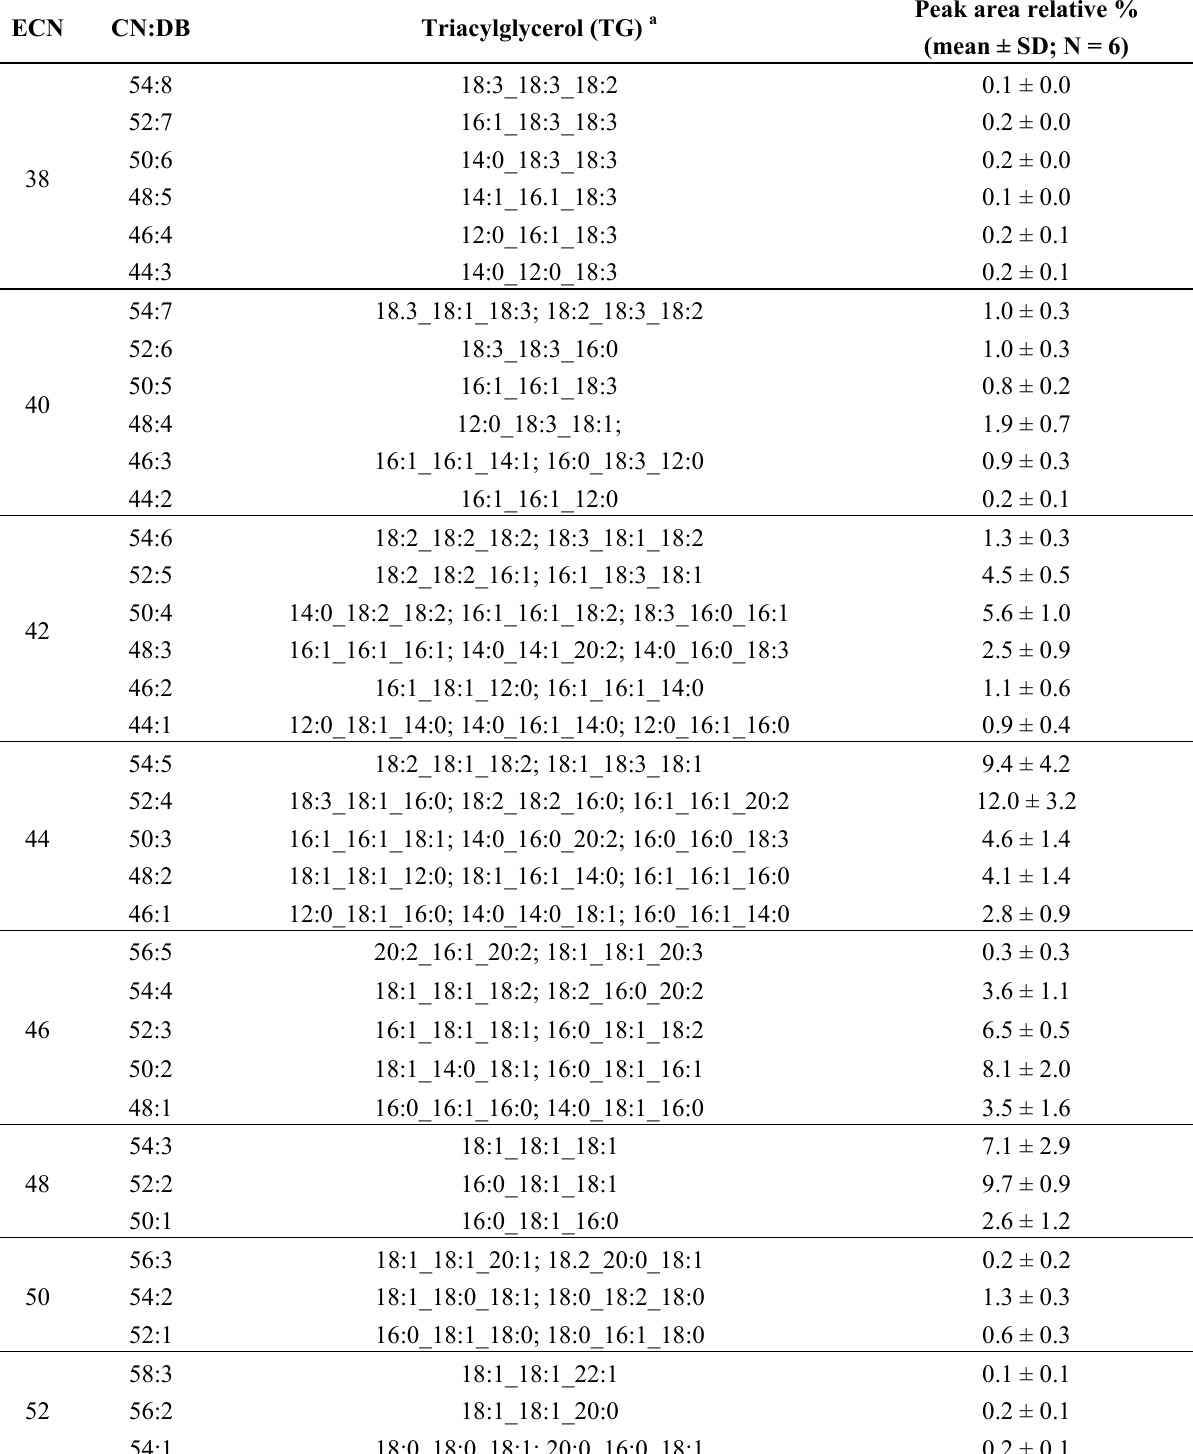
Table 5. Composition of triacylglycerols in the fat body of B. bohemicus